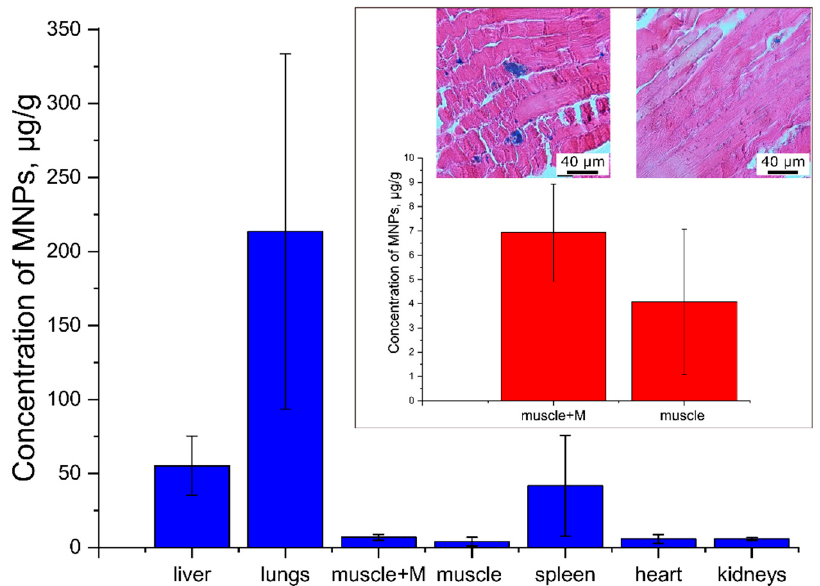
Figure 5. The magnetite tissue distribution measured by magnetometry. The predominant accumulation of magnetite in the lungs, liver and spleen. At the callout the concentration of magnetite in the intact muscle and the muscle exposed to the magnetic field as well as the histological picture of these muscles is presented (in insert). An increase in the concentration of magnetite by 70% compared with the intact limb was observed. Microaggregates of magnetite particles in the capillaries and venules were found.